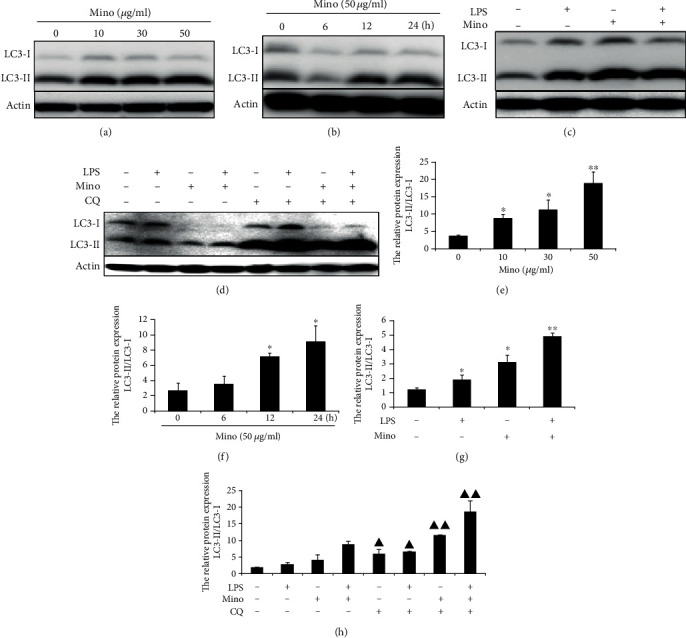
Minocycline induced autophagy in THP-1 cells. (a) Minocycline induced autophagy in a dose-dependent manner. THP-1 cells were treated with indicated concentration of minocycline for 12 h. (b) THP-1 cells were treated with 50 μg/ml minocycline for 6, 12, and 24 h. (c) THP-1 cells were stimulated by 1 μg/ml LPS followed with 50 μg/ml minocycline for 12 h. (d) THP-1 cells were treated in the absence or presence of chloroquine (CQ, 20 μM) for 1 h and then stimulated with 1 μg/ml LPS without or with 50 μg/ml minocycline for 12 h. (e, f, g, and h) The relative expression of the ratios of LC3-II to LC3-I. Data were represented as the means ± S.D. (N = 4, ∗p < 0.05, ∗∗p < 0.01 vs. control; ▲p < 0.05, ▲▲p < 0.01 vs. the corresponding group without CQ). Mino: minocycline; CQ: choroquine.